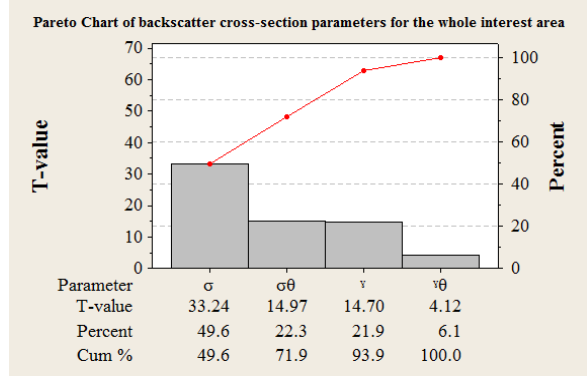
Figure 6. Pareto chart of backscatter cross-section parameters over the interest area in the Bournemouth study